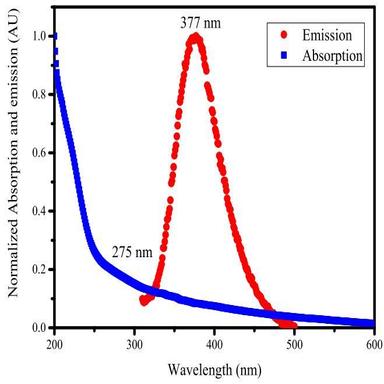
Normalized UV–VIS absorption spectrum and fluorescence emission curve embedded together.